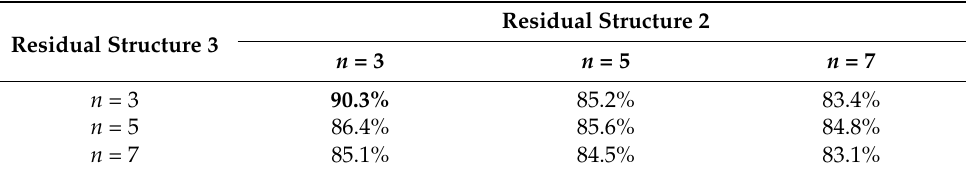
Table 2. The recognition accuracy of different network structures on dataset 2b (n represents the size of the convolutional kernel).